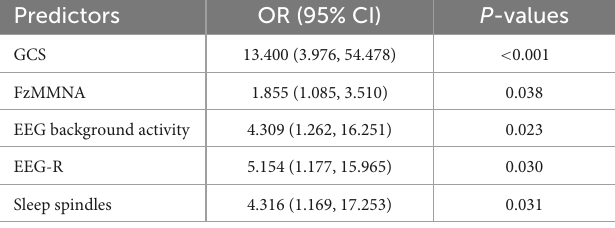
TABLE 2 Binary logistic regression analysis of the predictors of consciousness recovery in comatose patients.